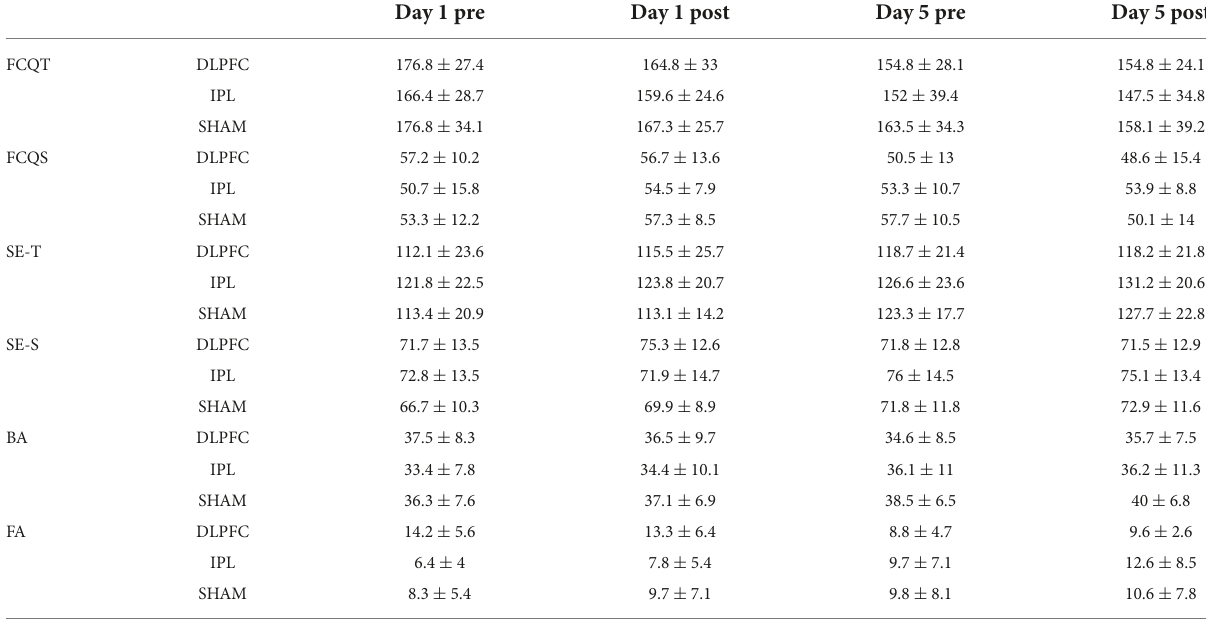
TABLE 2 Craving, self-esteem, body appreciation questionnaires scores as well as results of Go/No-go